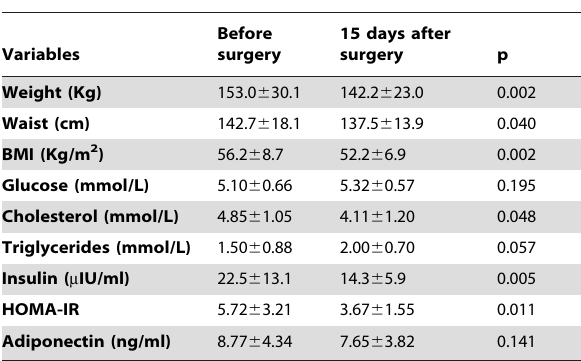
Table 3. Course of biochemical and anthropometric variables in the morbidly obese patients before and after bariatric